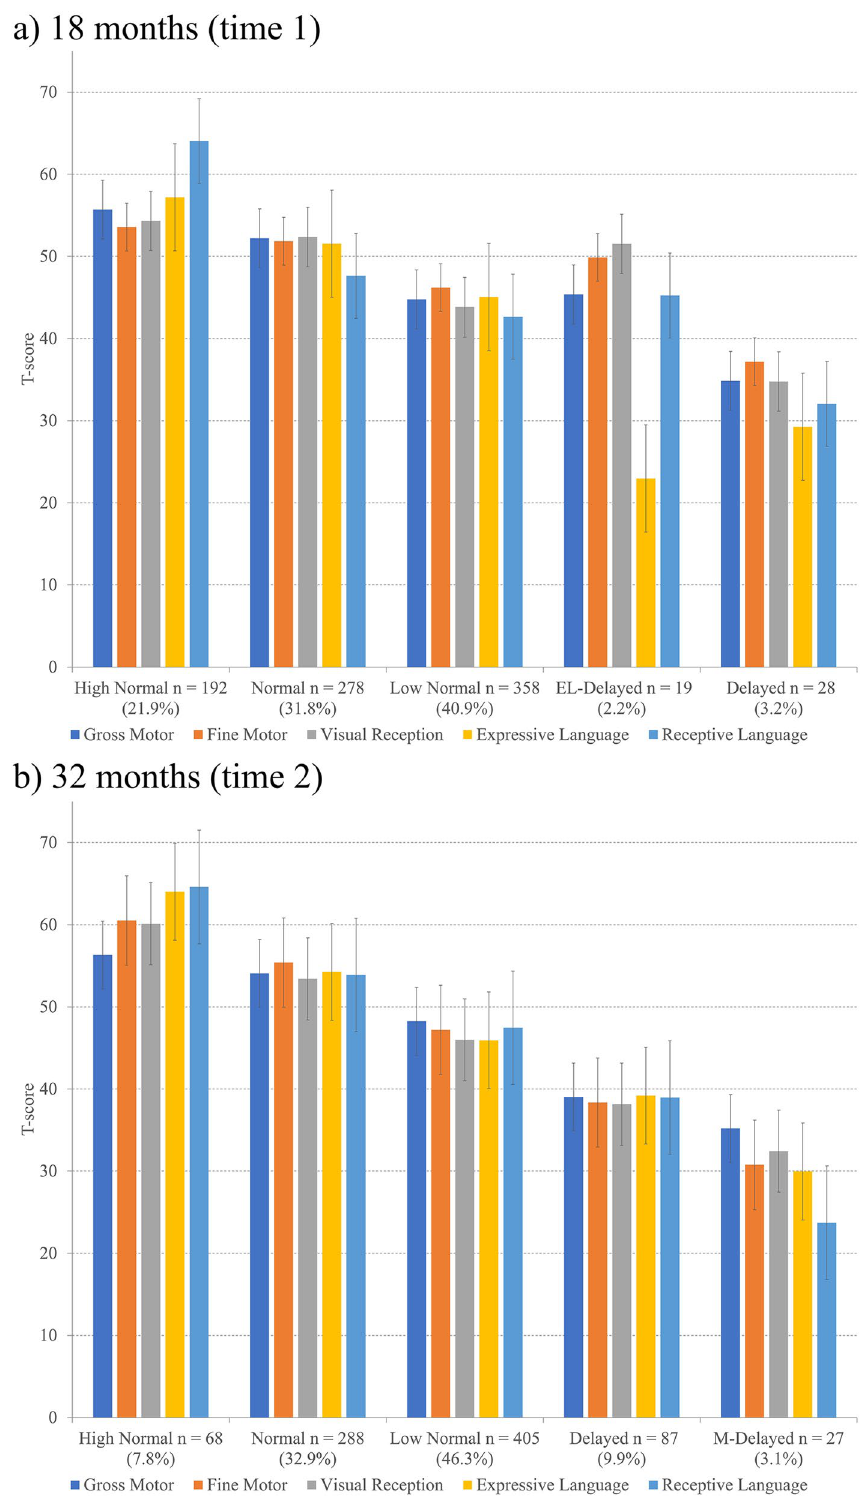
Figure 1. Latent class structure by neurodevelopmental domains at 18 months ( A ) and 32 months ( B ) ( n = 875). EL-delayed expressive language delayed, M-delayed markedly